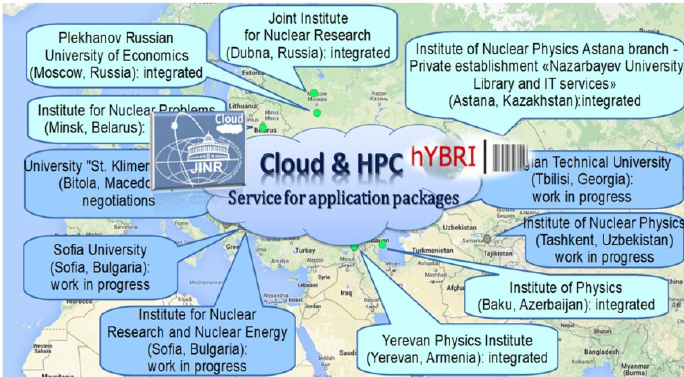
Fig. 2. Map with the distributed cloud infrastructure participants .